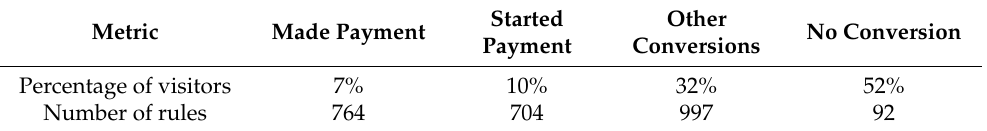
Table 2. Rules obtained in each class of visitors. Columns 2 to 5 indicate the class of visitor. Seven percent of the sessions are visitors from the class Made payment, where we found 764 rules. Con- versely, fifty-two percent of the sessions are visitors from the class No conversion, where we found only 92